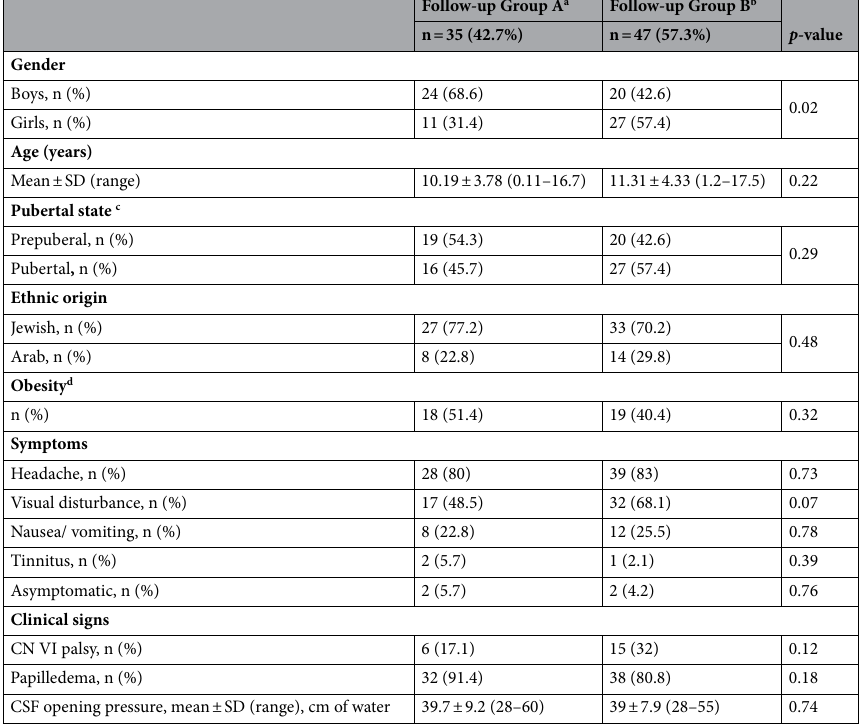
Table 1. Demographic and clinical characteristics at presentation of the study cohort. SD, standard deviation; CN, cranial nerve; NA not available. a Continuous follow-up in tertiary center; b Follow-up in community clinics or no follow-up at all; c Girls over the age of 10 years and boys over the age of 11 years; d Weight percentile ≥ 95%, data was not available for 5 children.